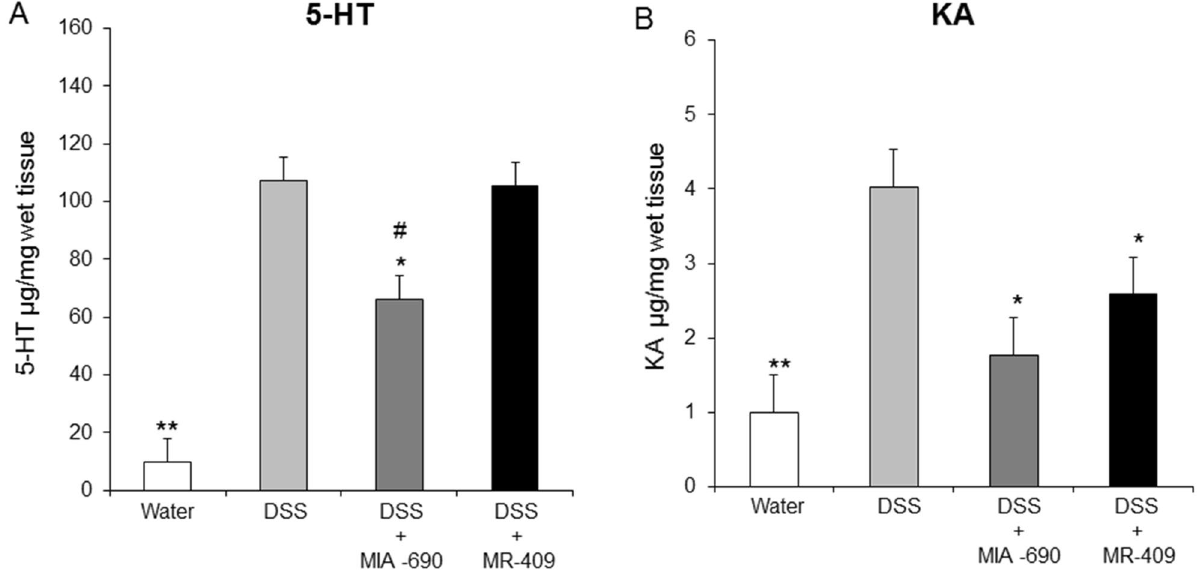
Figure 9. Effects of MIA-690 (5 µg) and MR-409 (5 μg) on 5-HT ( A ) and KA ( B ) levels in colon segments of DSS-induced colitis mice (n = 6 for each group of treatment). Data are expressed as means ± S.E.M. and analyzed by analysis of variance (ANOVA) followed by Bonferroni post-hoc test * p < 0.05 ** p < 0.01 versus DSS treated mice; # p < 0.05 versus MR-409 treated